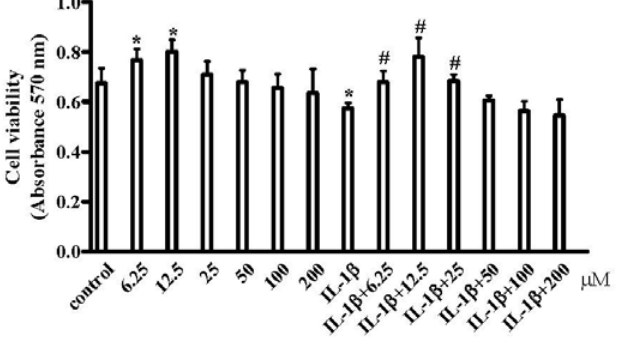
Figure 1. Effects of resveratrol and IL-1β on the viability and proliferation of chondrocytes in vitro . Serum-starved (0.5% FCS) human articular chondrocytes from OA patients were treated with various concentration of resveratrol (0, 6.25, 12.5, 25, 50, 100, 200 µM) only or in the presence of 10 ng/mL IL-1β for 24 h. Cell viability was examined using the MTT (3-(4,5-dimethylthiazol-2-yl)-2,5-diphenyltetrazolium bromide)method. Treatment groups were analyzed in triplicate and the data expressed as the mean ± SD from three independent experiments. p < 0.05, * vs. control, # vs.